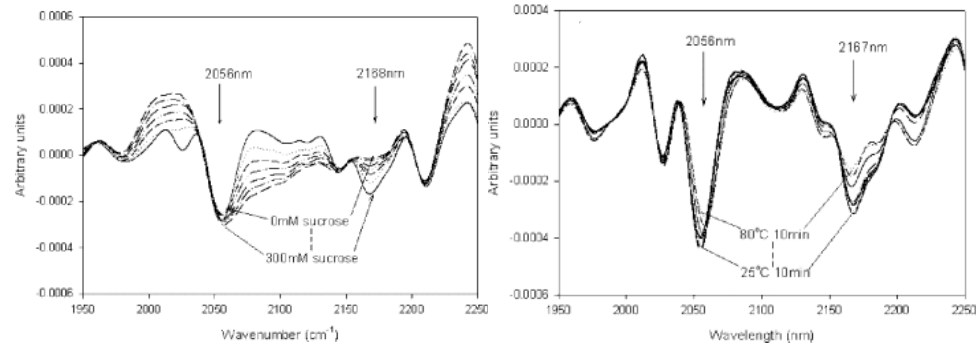
Figure 5. NIR (near-infrared) spectra as second derivatives of structural studies on lyophilized cytochrome c. The influence of sucrose content on the preservation of secondary structure is shown in the left spectra, while the influence of temperature on protein stability can be seen in the right ones. Reproduced with permission from [51], Wiley, 2005.